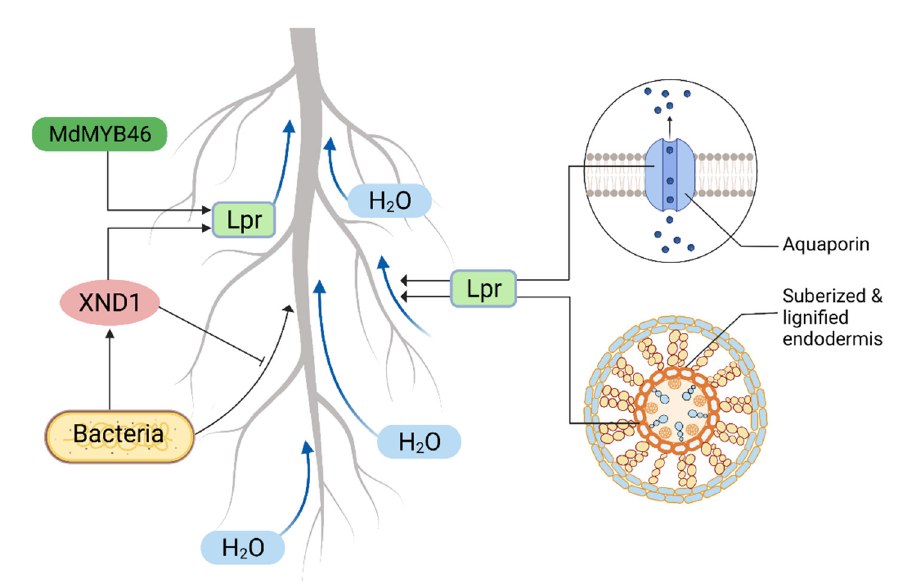
Figure 2. Molecular and cellular regulators of root hydraulics. XND1 reduced root hydraulics (Lpr) by inhibiting xylem formation. Bacteria increase XND1 activity and XND1 reduces the pathogenicity of the bacteria; thus, Lpr is regulated without being affected by bacterial wilt. MdMYB46 influ- ences Lpr by modifying root xylem vessel formation. Aquaporins control Lpr by regulating radial water transport. Suberin reduces Lpr and lignin indirectly reduces Lpr by facilitating xylem vessel development.